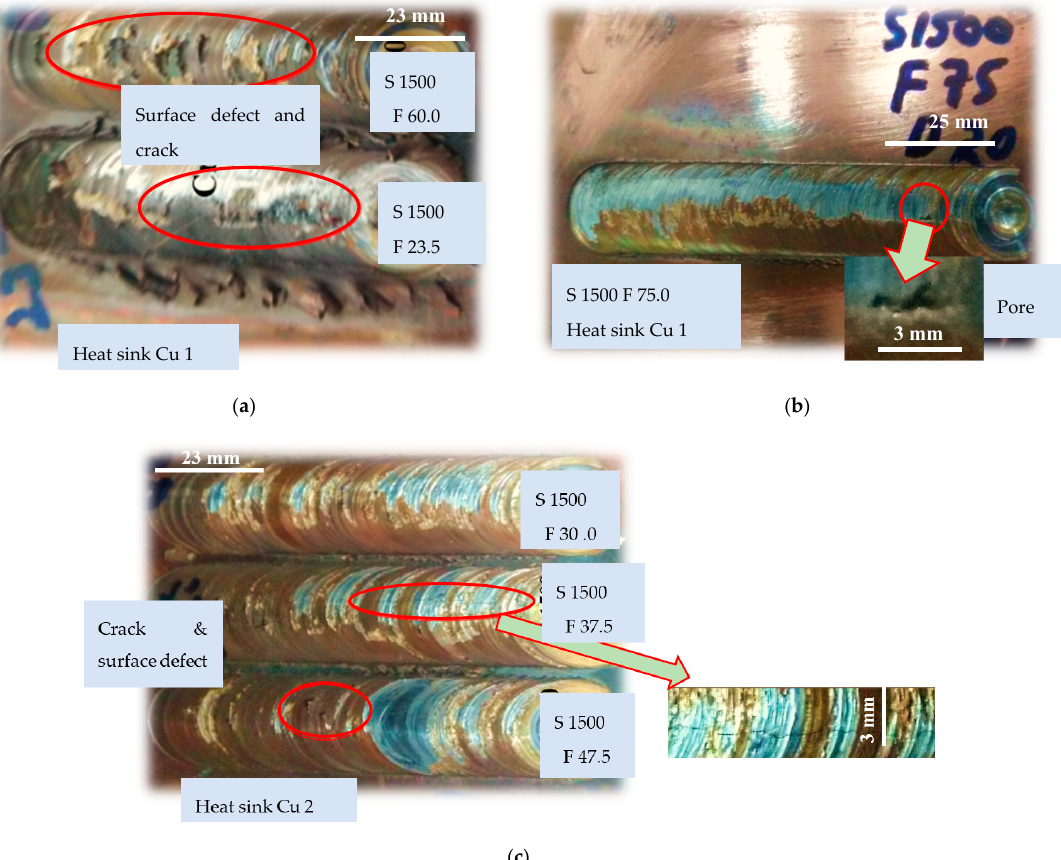
Figure 12. Redesign of dissimilar Cu-2219 Al lap joints fabricated by WC square-tool and using heat sink: ( a , b ) Cu 1 and ( c ) Cu 2.